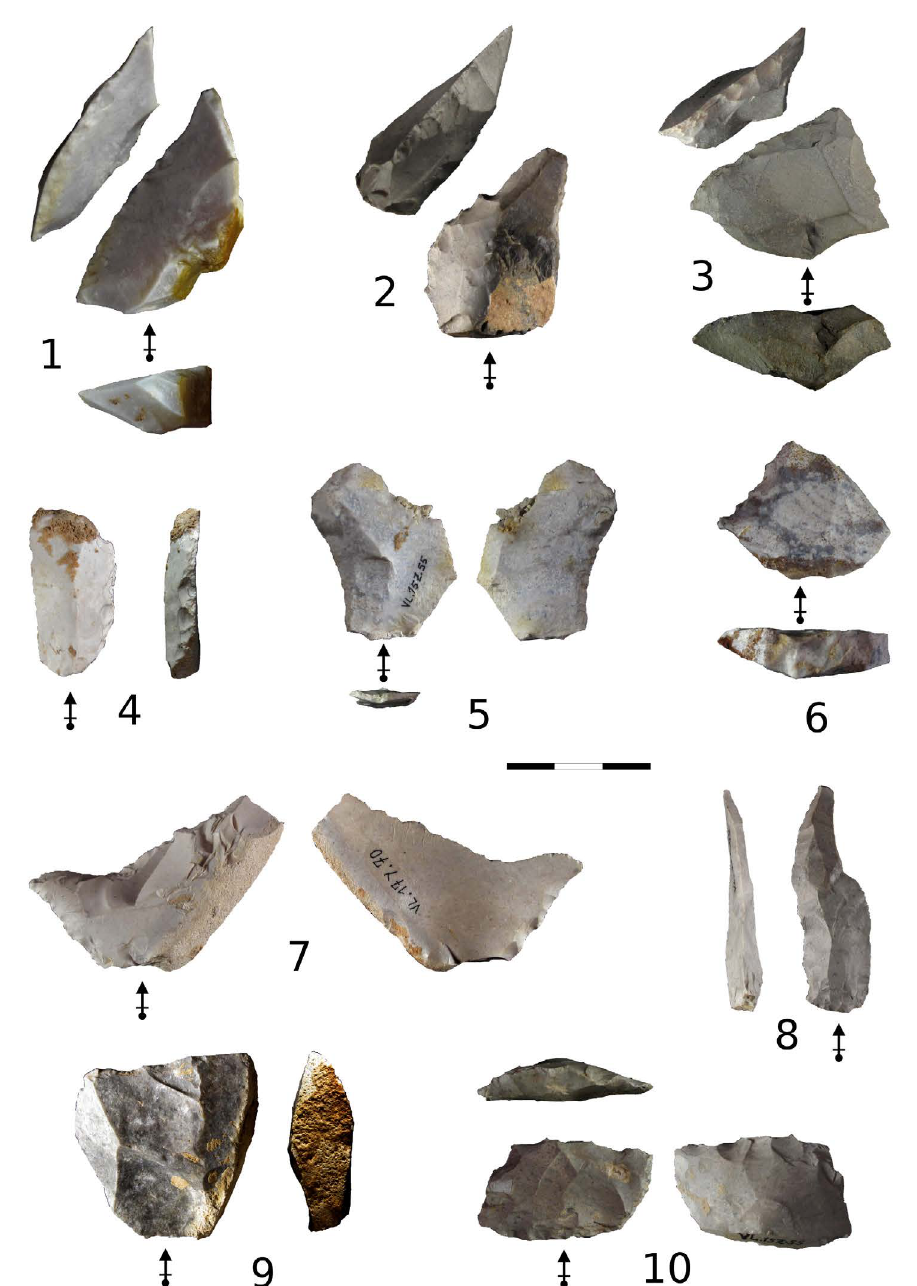
Figure 9. Non-Urgonian flint artefacts. 1-3 dejeté side-scrapers; 4: lateral side-scraper; 5: piece with retouch on ventral surface; 6: denticulate; 7, 10: bifacial denticulates, no. 10 made on a resharpening flake; 8: blade; 9: retouched